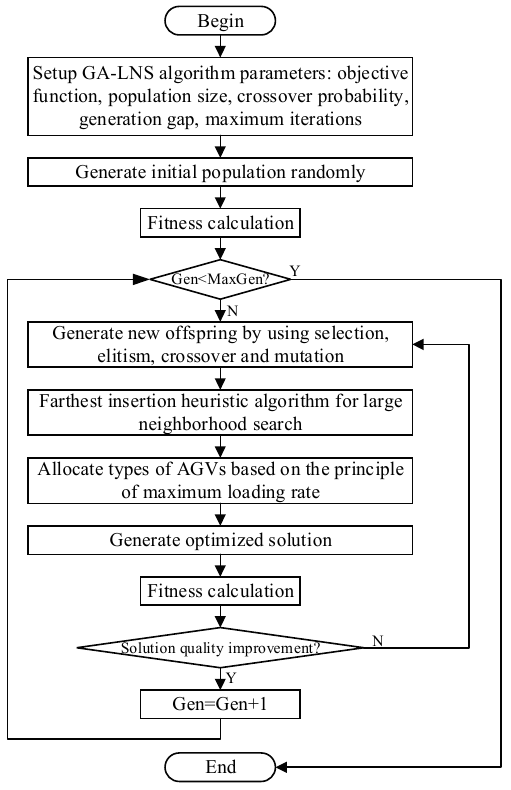
Figure 7. The flow-chart of GA-LNS.